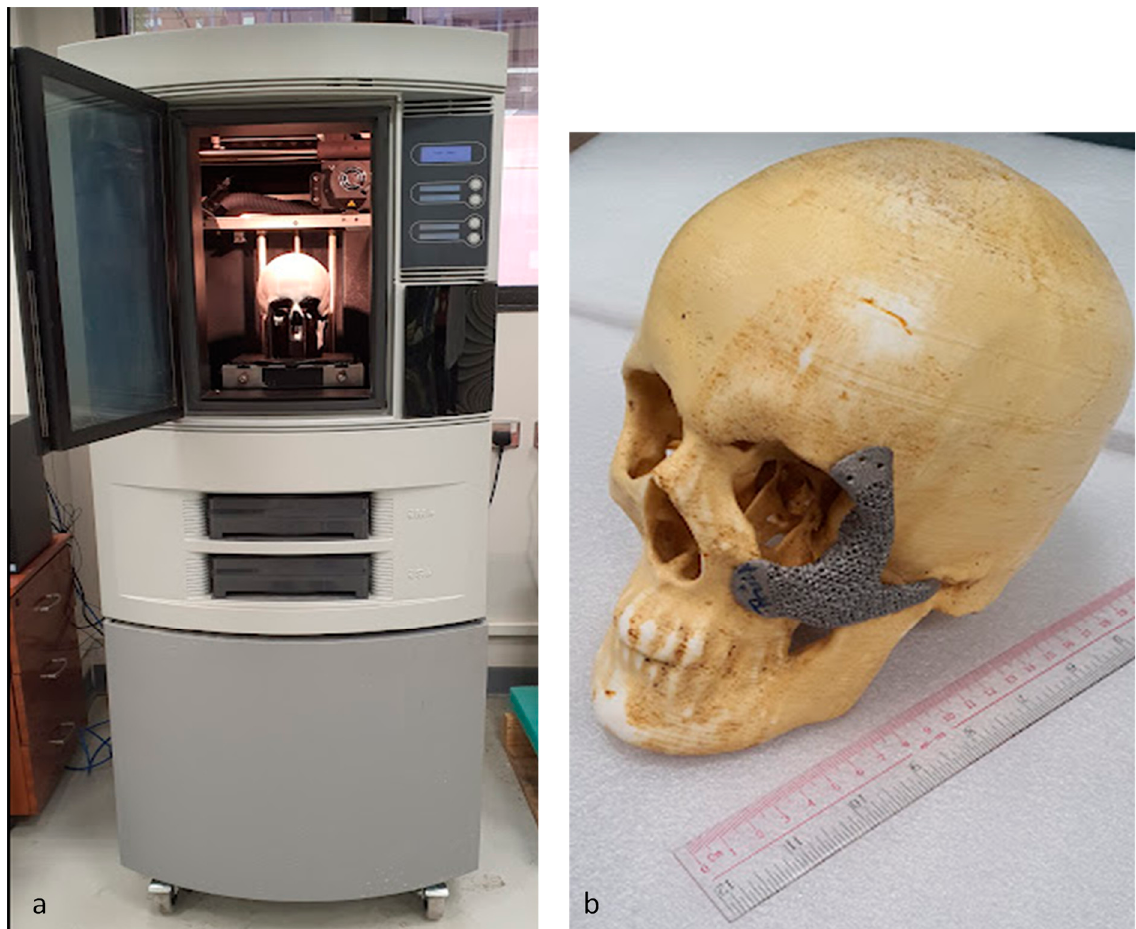
Figure 14. ( a ) FDM machine and ( b ) EBAM-built scaffold fitted on the ABS skull model for validation.